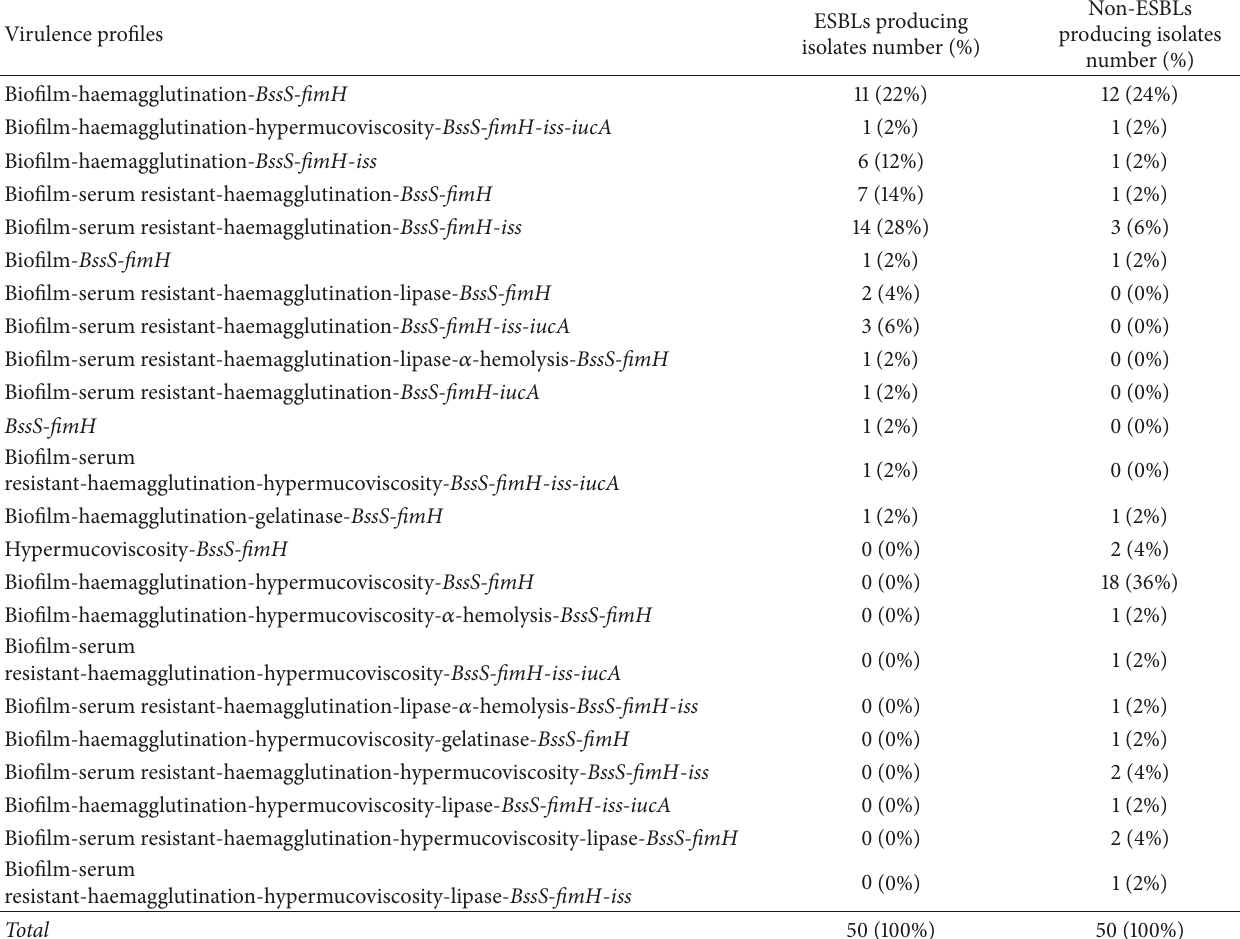
Table 4: Virulence profiles associated with ESBLs and non-ESBLs producing K. pneumoniae i